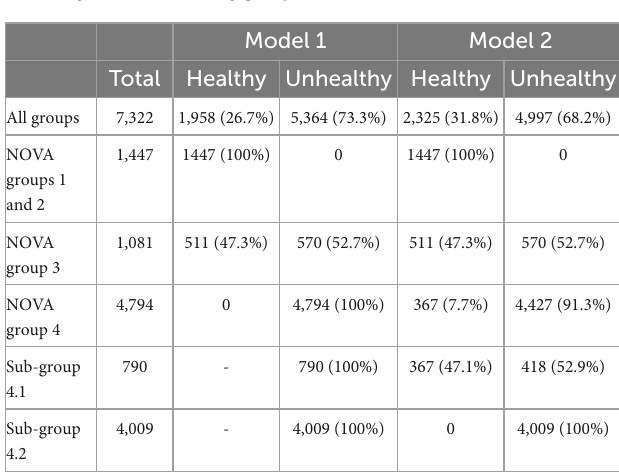
TABLE 3 Frequency and proportion of food items classified as healthy and unhealthy for each model by